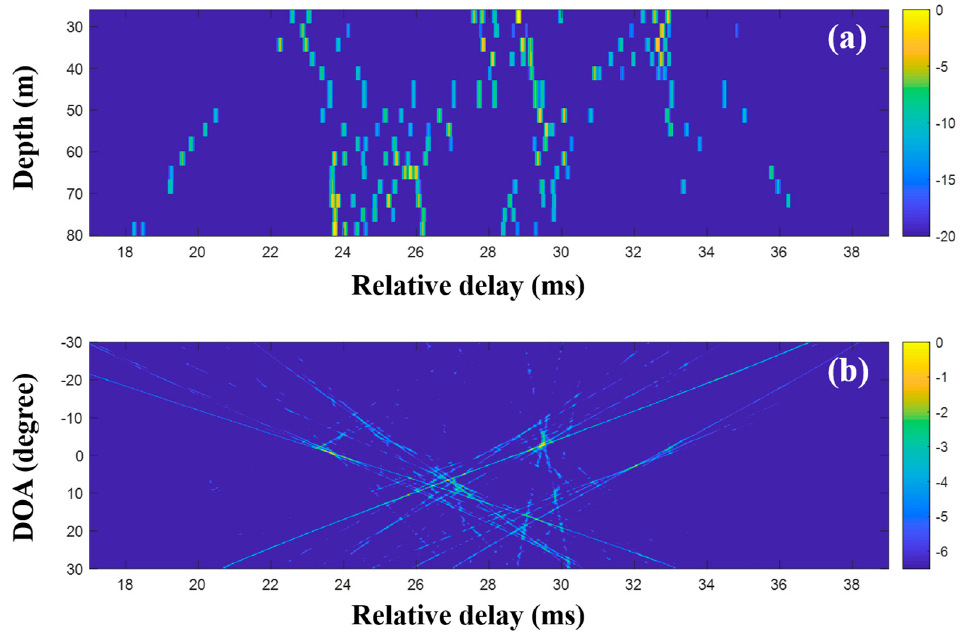
Figure 15. Direction-of-arrival (DOA) estimation using compressive sensing (CS) with a single snapshot captured by the vertical line array (VLA) in SAVEX15 (11–31 kHz): ( a ) arrival structures via sequential CS usage to the signals at the VLA, and ( b ) DOAs using delay-and-sum beamforming with the arrival structures.